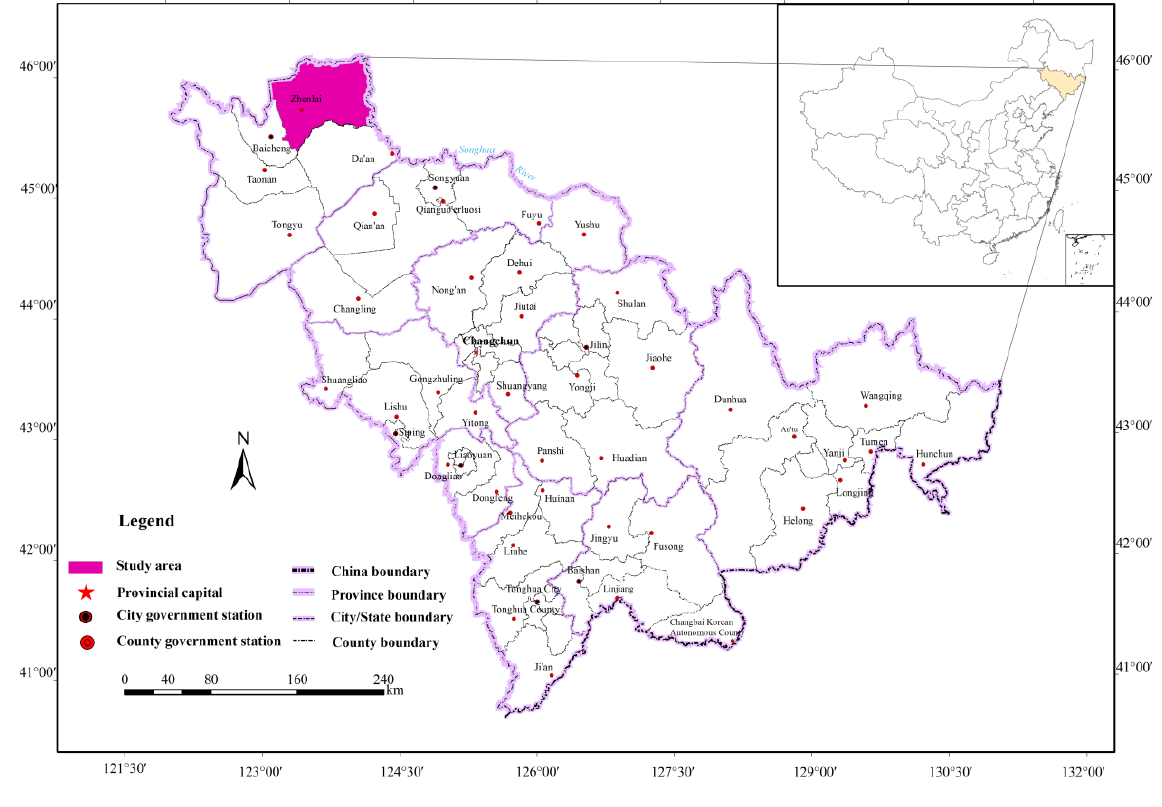
Figure 1. The study area, Zhenlai